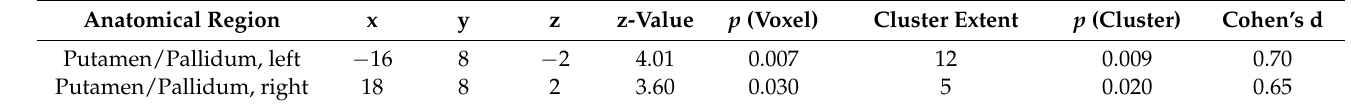
Table 2. Medication effects inferred by combined hypothesis testing for significant Group-by-Time interaction in the presence of significant pre-to-post-medication increase in IFC in ADHD